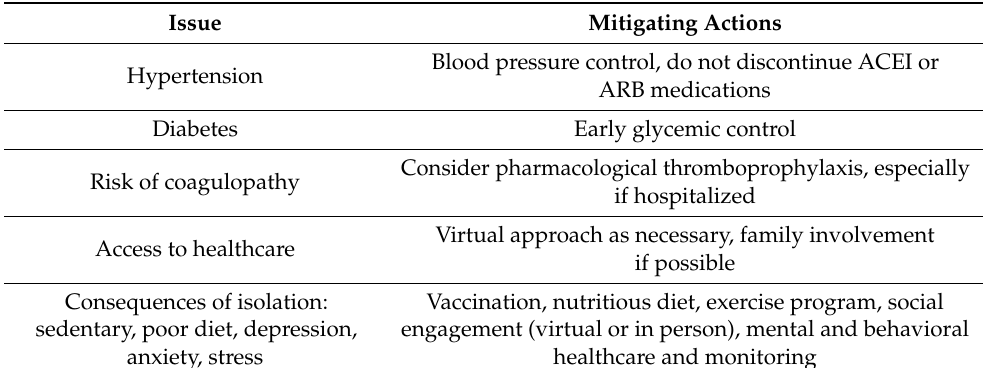
Table 3. Summary of key issues for older COVID-19 patients with